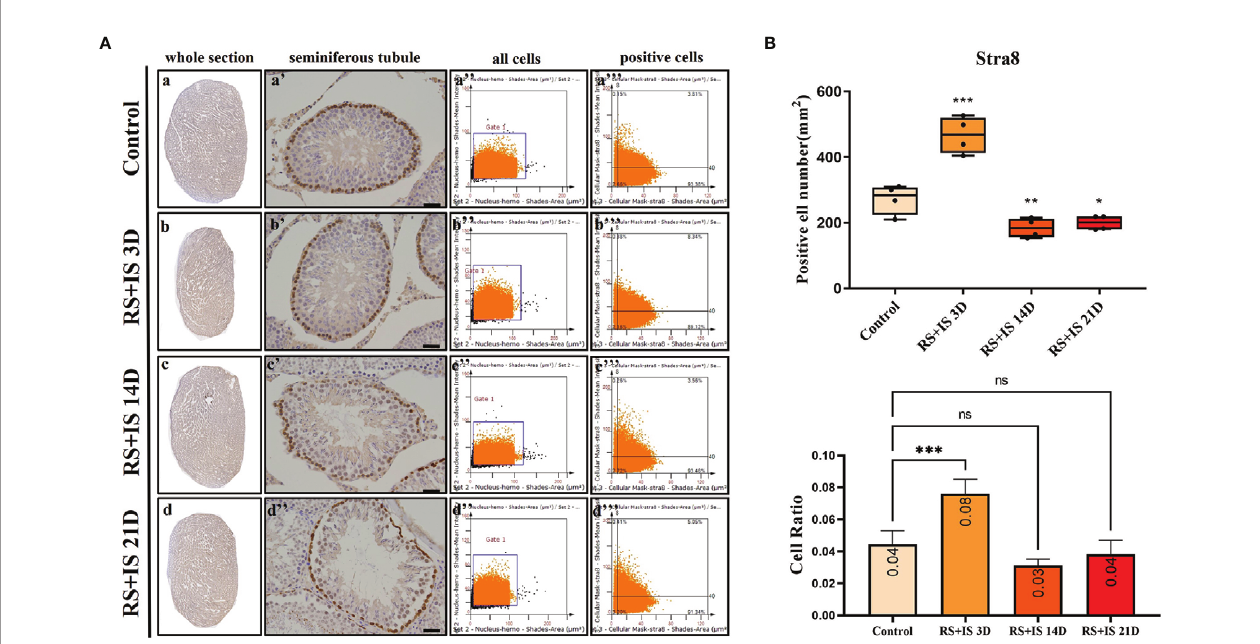
FIGURE 5 | (A) IHC expression of Stra8. (a – d) show the section of testis. (a ’– d ’ ) show the seminiferous tubule (Bars = 50 m m). (a ’’– d ’’ ) positive points represent all cells. (a ’’’– d ’’’ ) all the positive points in right upper quadrant represent the positive cells. (B) Box plot (upper) shows Stra8-positive cell counting number; each point represents one section. Bar plot (lower) shows Stra8-positive cell ratio (positive cell counting/all cell counting), n = 4. Values with different superscripts indicate signi fi cant differences between control and treatment groups on one-way ANOVA (* P < 0.05, ** P < 0.01, *** P < 0.001). ns, non-signi fi cant.